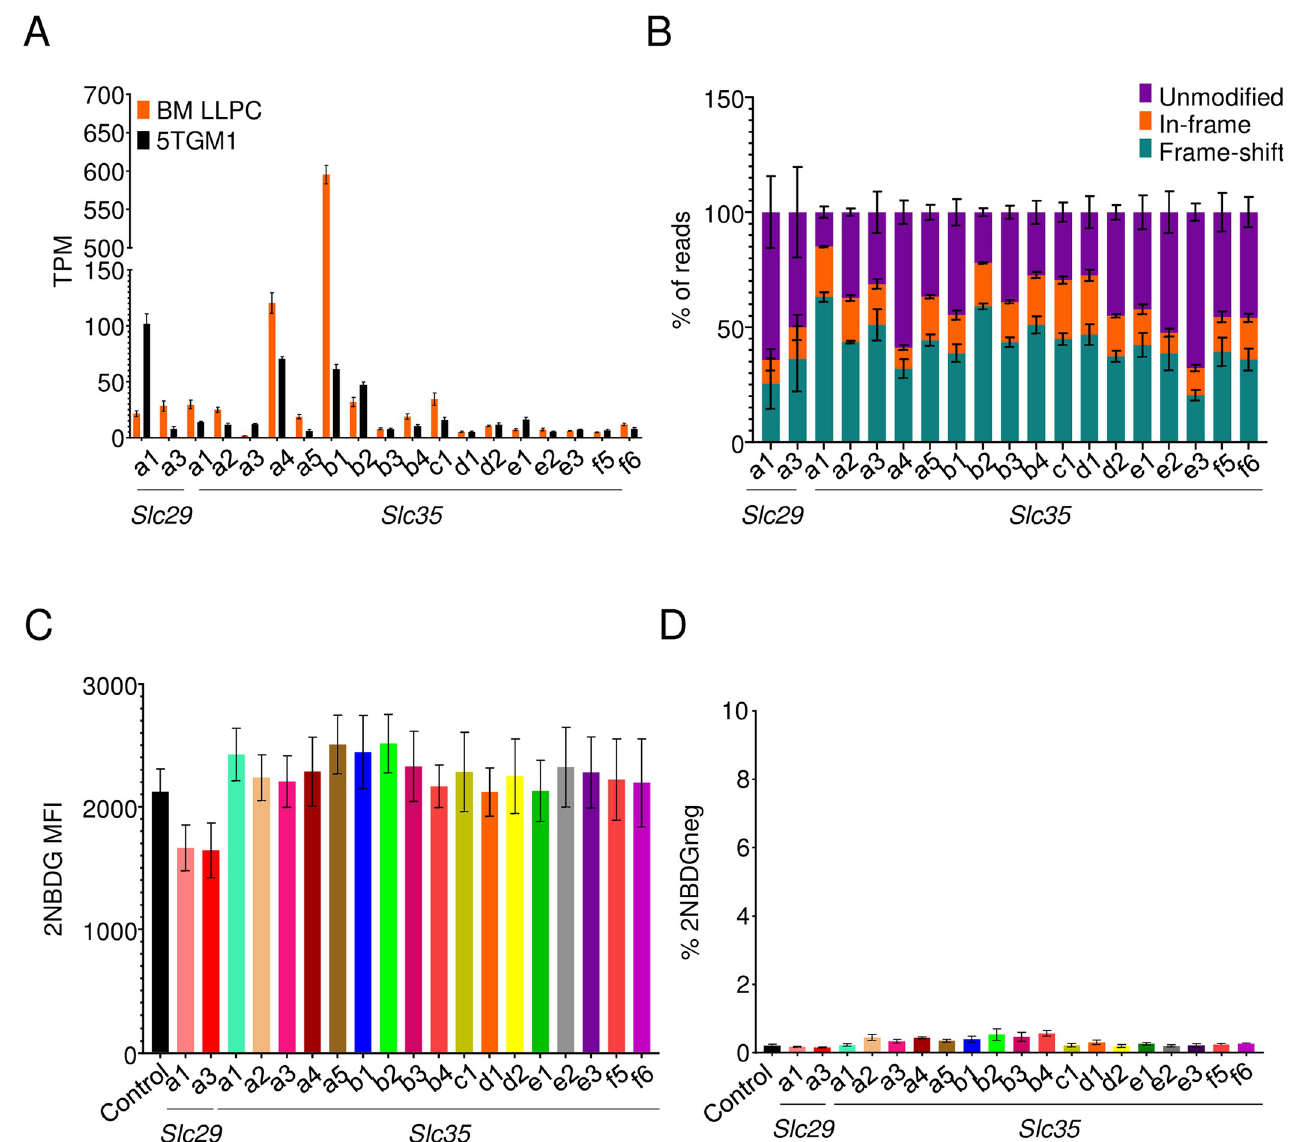
Fig 8. 2NBDG is not imported through nucleoside or nucleoside-sugar transporters. (A) TPM values of nucleoside and nucleoside-sugar transporters in ex vivo bone marrow (orange) plasma cells and 5TGM1 cells (black). Mean values +/- SEM are shown. (B) Estimation of indels in nucleoside and nucleoside- sugar transporter deleted cultures done as in Fig 5B. Mean values +/- SEM shown for each of the genes and modifications within it. Pooled data from three independent experiments. (C) 2NBDG uptake in deleted cultures. 5TGM1-Cas9 cells transduced with gRNAs targeting indicated nucleoside or nucleoside- sugar transporters (colored) or with a control gRNA (black). 2NBDG MFIs across three independent experiments are quantified and displayed with SEM. (D) Frequencies of 2NBDG negative cells in cultures described in (C). Pooled data from three experiments. No statistical significance observed with the Brown- Forsyth and Welch one-way ANOVA multiple comparisons